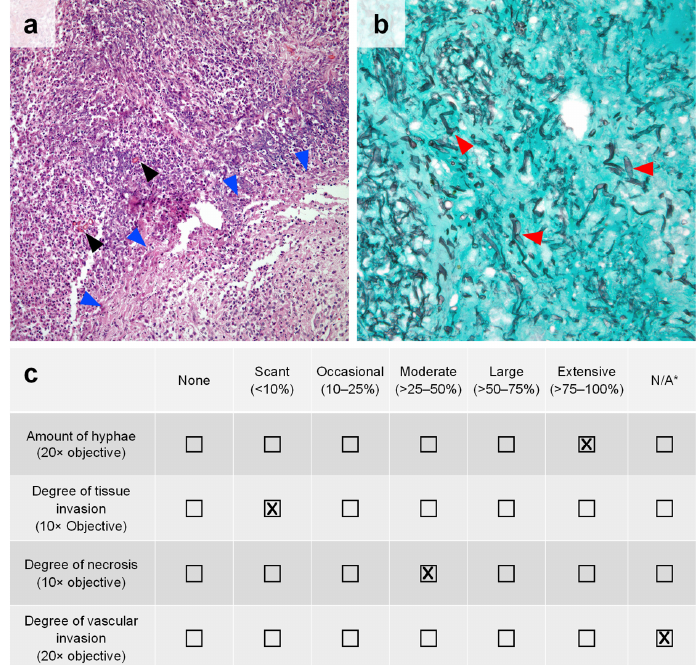
Figure 1. Pulmonary mucormycosis with histopathologic features of interest. ( a ) H&E staining of lung parenchyma with a moderate (>25–50%) amount of caseous necrosis (blue arrowheads) and acute suppurative inflammation plus scant (<10%) tissue invasion by MCR in cross-section (black arrowheads) at 10 × objective. ( b ) GMS staining of a pulmonary tissue highlighting an extensive (>75–100%) amount of broad hyphae (red arrowheads) characteristic of MCR at 20 × objective. No vessels are present on the slide to evaluate vascular invasion. ( c ) Example scorecard used for the semi- quantitative assessment of included pulmonary MCR cases based on the amount of histopathologic features present in the images shown in panels ( a , b ). * N/A = not applicable (histological feature was not present on the slide for the pathologist to